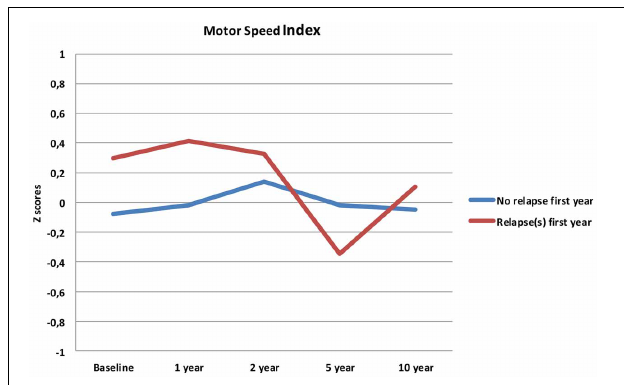
FIGURE 4 | Motor Speed index from baseline to 10 year follow-up, split by early